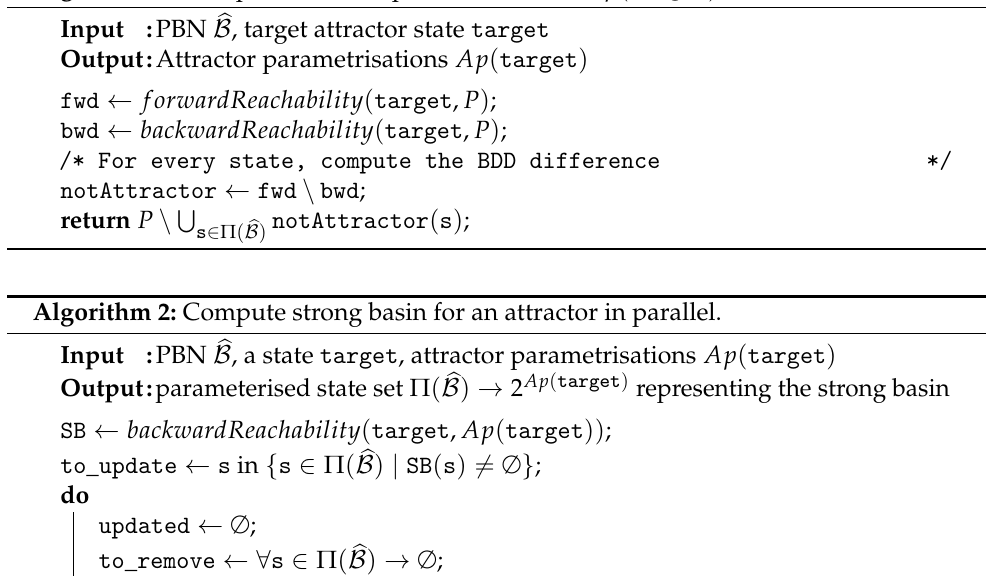
Algorithm 1: Compute attractor parametrisations Ap ( target ) .